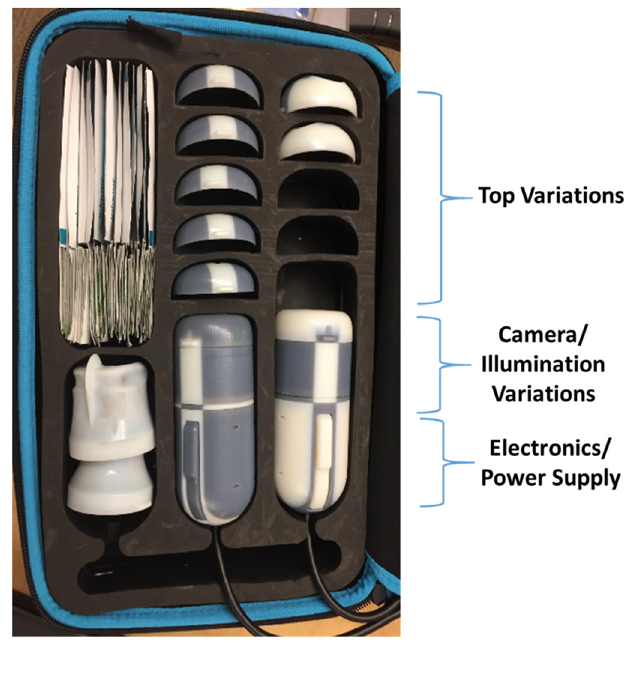
Figure 19. Phase I field-kit.